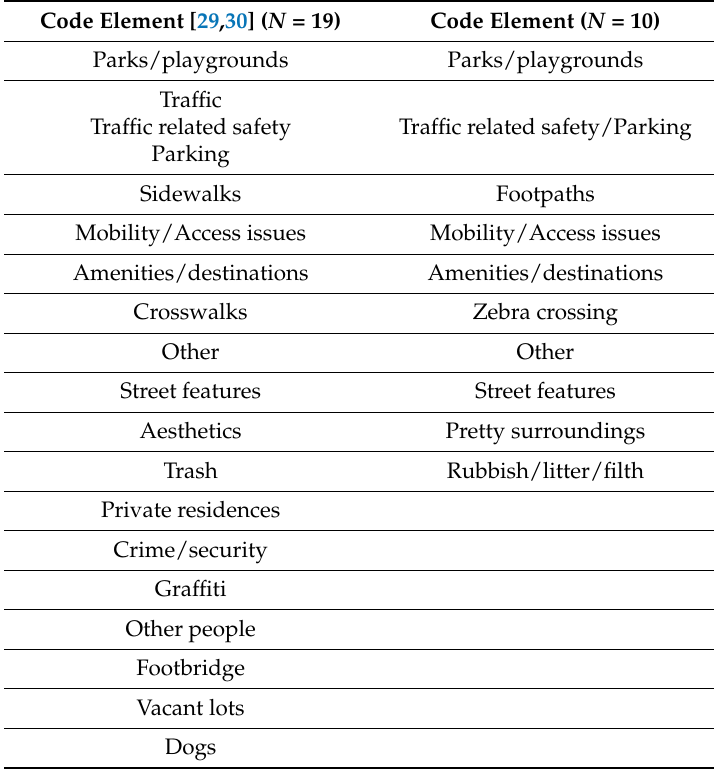
Table 1. The coded elements used here to derive the three issues prioritized by the citizen scientists during the Discuss session, January